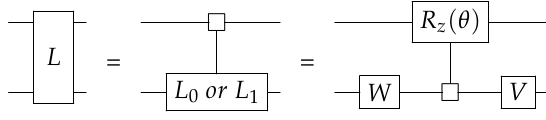
Figure 11. Decomposition of the L matrix in QSD